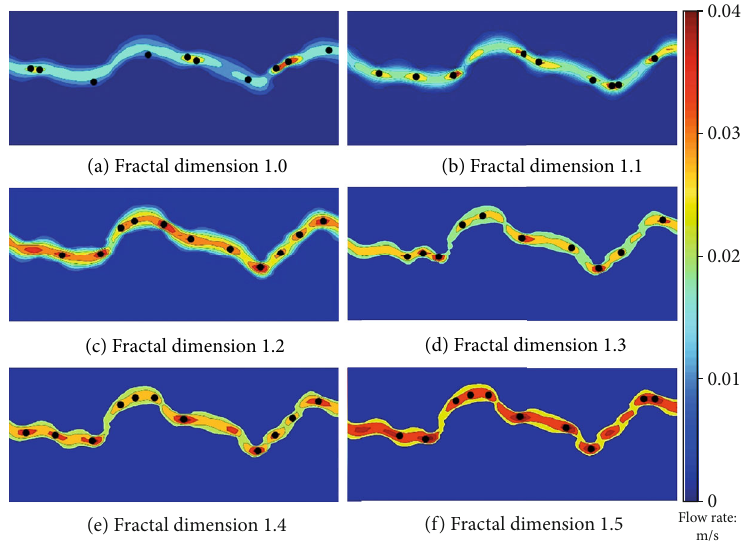
Figure 10: Flow contours with circular particles in fractures with varying fractal